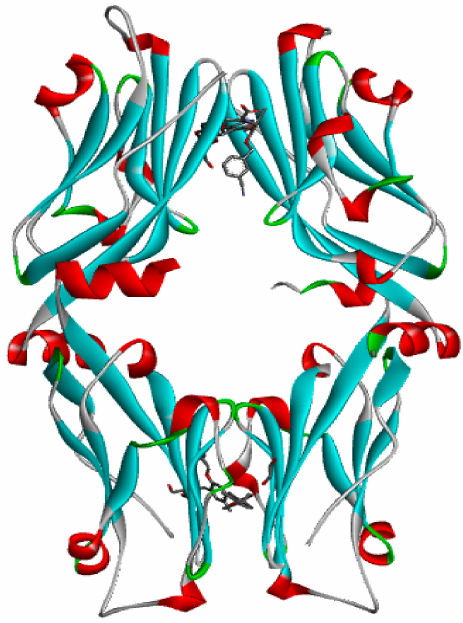
Figure 6. The crystal structure of Bristol–Meyers–Squibb (BMS)-1001 and hPD-L1 (PDB ID: